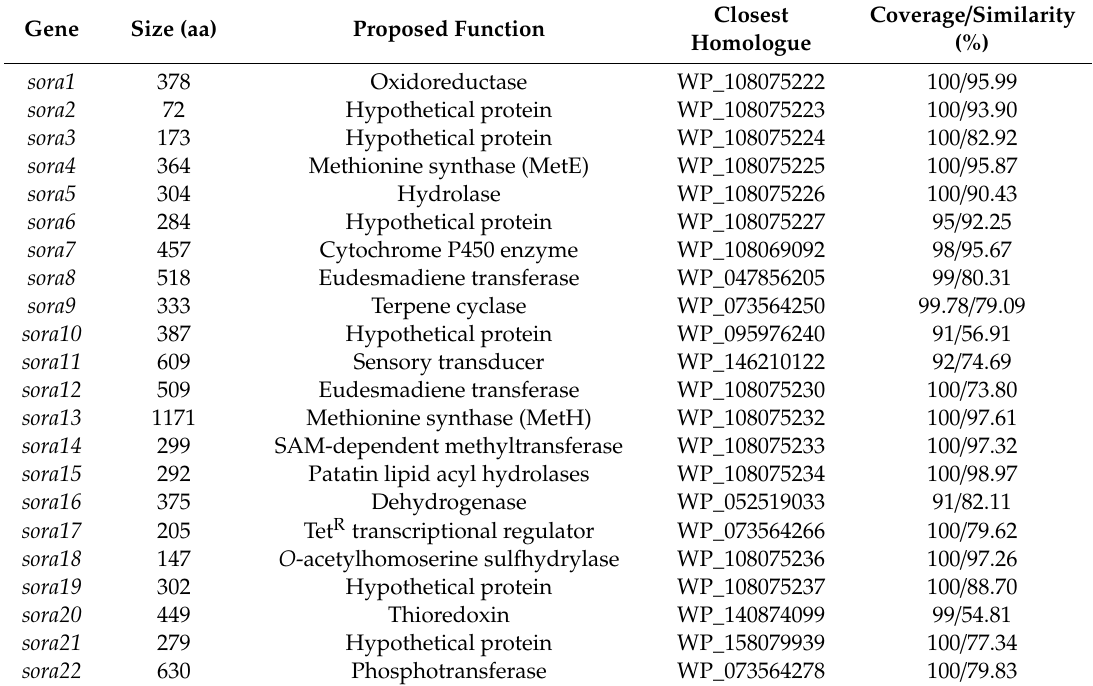
Table 4. Predicted functions of the proteins encoded by the (2-hydroxy)sorangiadenosine biosynthetic gene